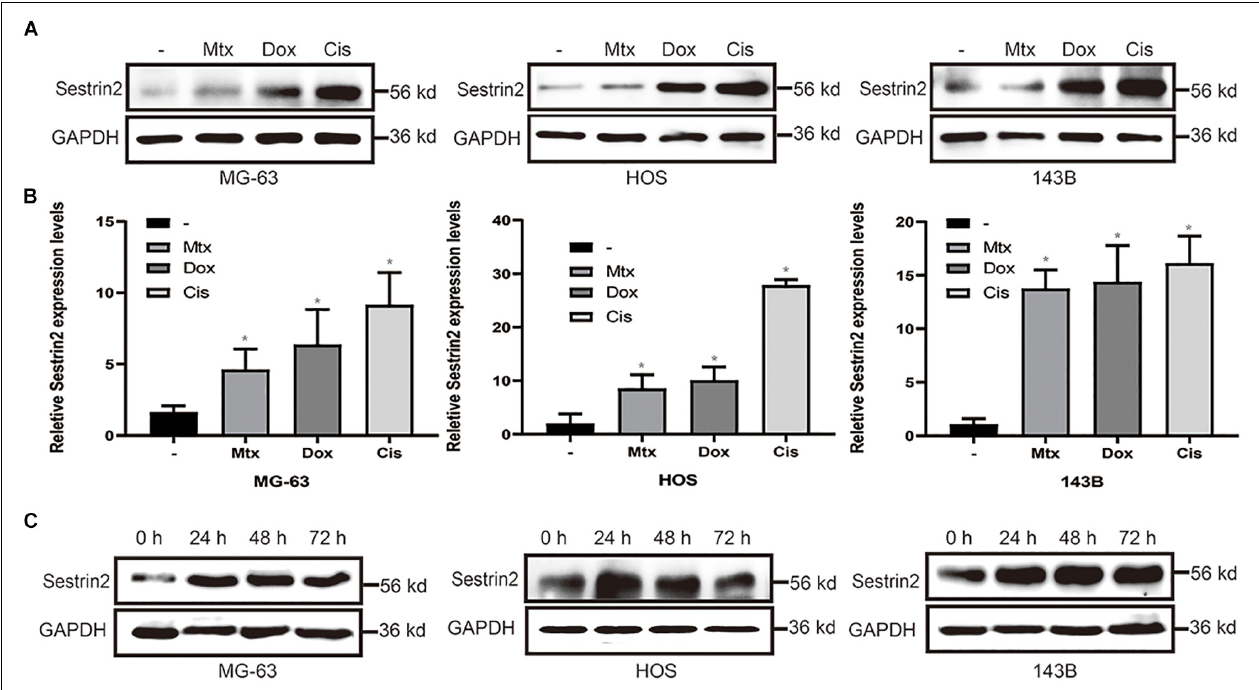
FIGURE 1 | Chemotherapeutic agents increased the expression of SESN2 in osteosarcoma cells (A,B) . After treatment with Cis (20 µ mol/L), Dox (0.2 µ g/mL) or Mtx (50 µ mol/L), the expression level of SESN2 in osteosarcoma cells was detected by western blot (A) ( n = 3), and the SESN2 mRNA level was detected by quantitative real-time PCR (B) ( n = 3). Western blotting was used to detect SESN2 expression in MG-63, HOS, and 143B cells after Cis (20 µ mol/L) treatment for 24 to 72 h (C) ( n = 3). The data are presented as the mean ± SD. * p < 0.05 vs. the – group.